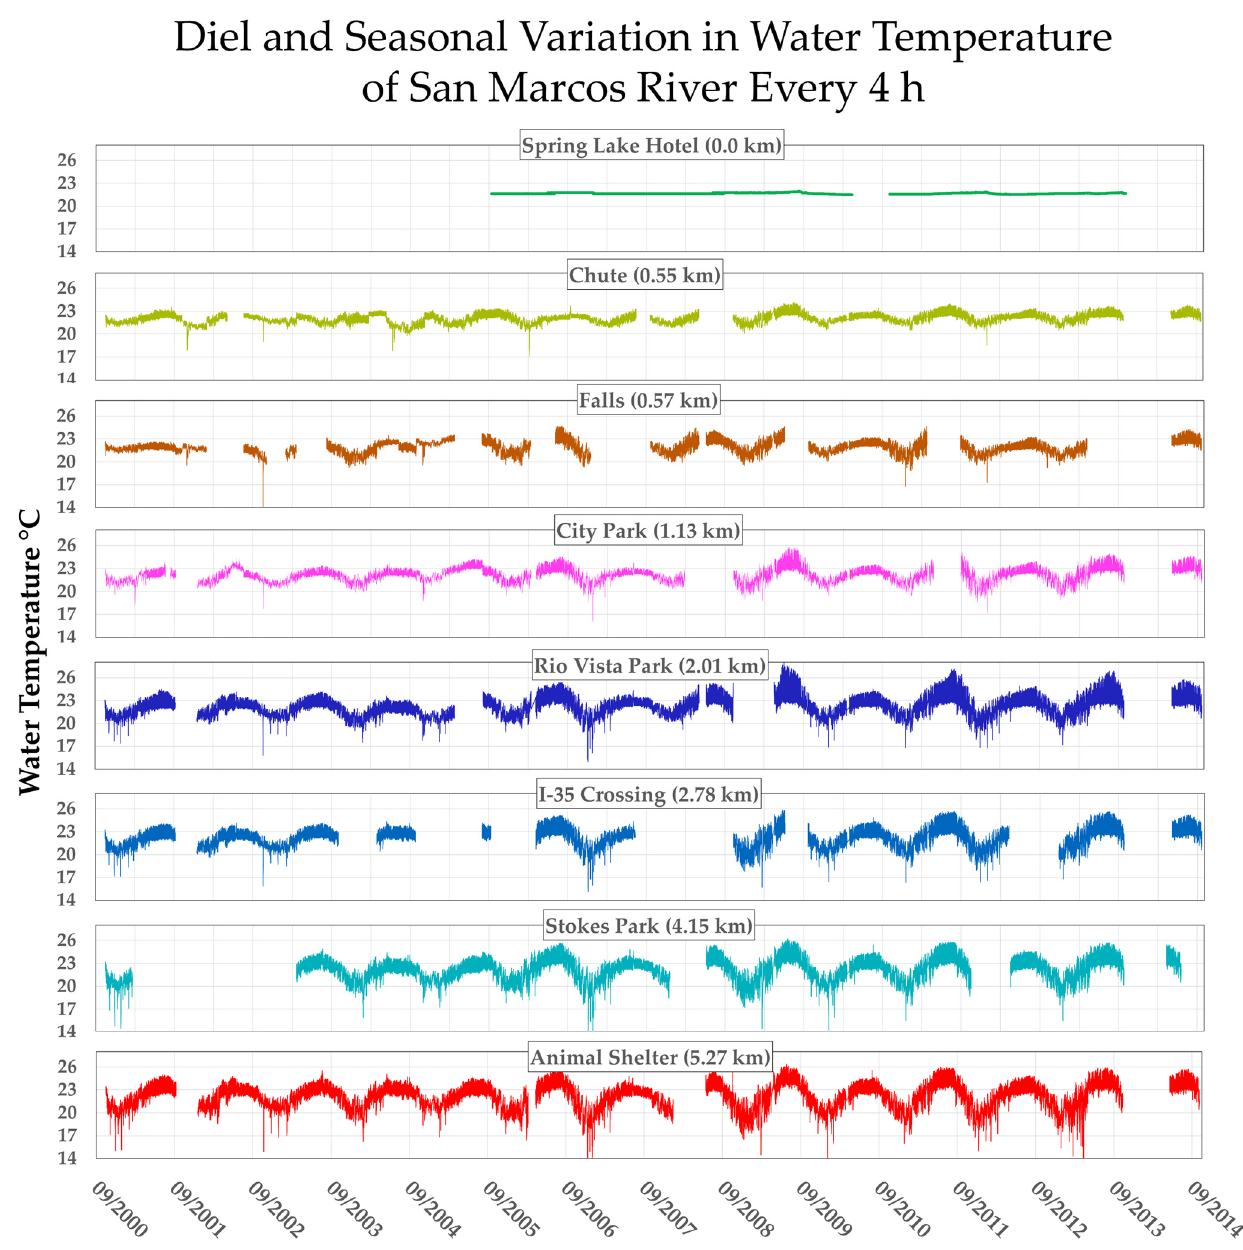
Figure 5. Seasonal and diel variability of water temperature over 14 years recorded at various sta‑ tions downstream from headspring (graciously shared by BIO‑WEST, Inc.; gaps are memory‑full errors, losses due to spates, or vandalism; transients are due to cold fronts and winter spates from flashy tributaries.